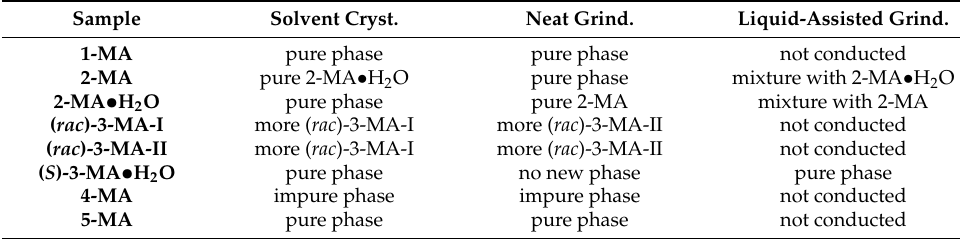
Table 1. Overview on the conducted crystallization methods for 1 – 5 maleates. Sample Solvent Cryst. Neat Grind. Liquid-Assisted